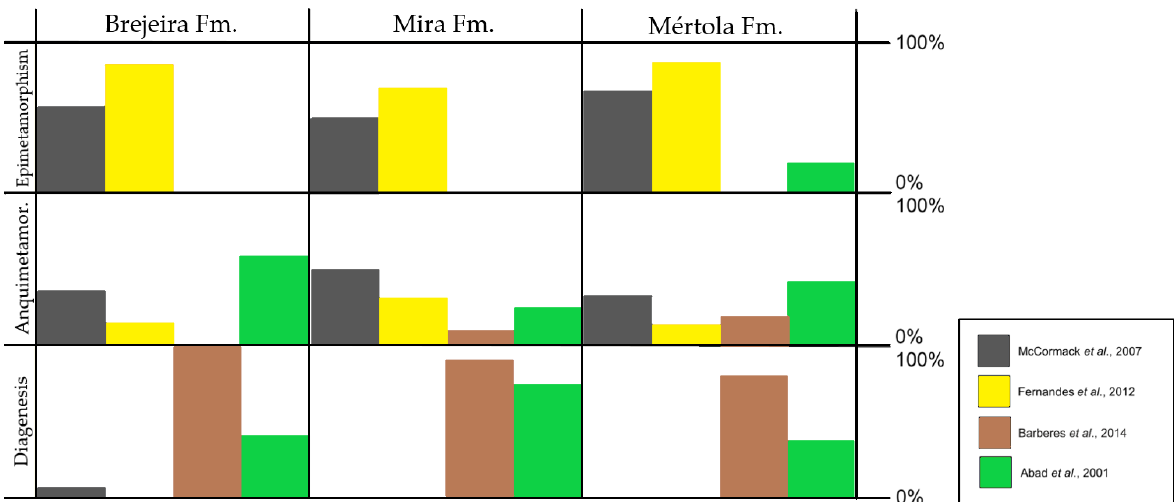
Figure 8. Comparative graph of VR values from Fernandes et al. [10], McCormack et al. [9], illite crystallinity [8], and the estimated maturation by Barberes et al. [33]. The data are divided according to the percentage of occurrence samples for each low-grade metamorphic zone in the three formations. This graph was built based on Kisch [34] proposal for comparison between the VR values, the low-grade metamorphic zones (diagenesis, anquimetamorphism, and epimetamorphism); adapted from Barberes et al.